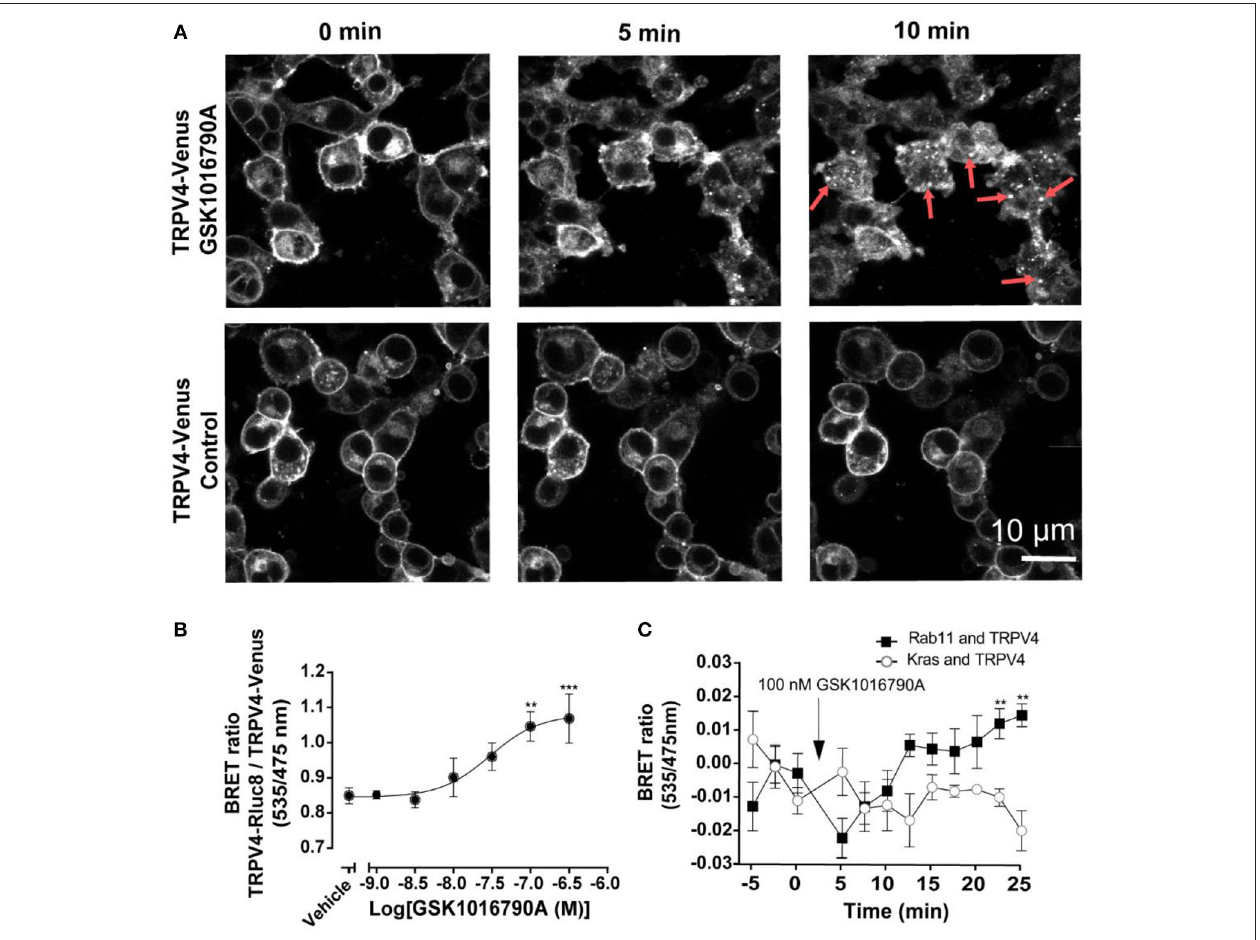
FIGURE 2 | GSK1016790A induced the endocytosis and complexation of TRPV4 into recycling endosomes. (A) Confocal microscopy of HEK293 cells stably expressing TRPV4-Venus, showing the stimulation of TRPV4 with 100nM GSK1016790A induced the internalization and complexation of TRPV4 channels. (B) Stimulation of TRPV4 with GSK1016790A increased the BRET signals between tagged TRPV4 channels. (C) BRET assay showing that TRPV4 stimulation with GSK1016790A increased the interaction of TRPV4 channels with Rab11 while reducing the interaction with Kras. Data in (B,C) represent the mean ± SEM. of four independent experiments performed in duplicate. ** p < 0.01 and *** p <